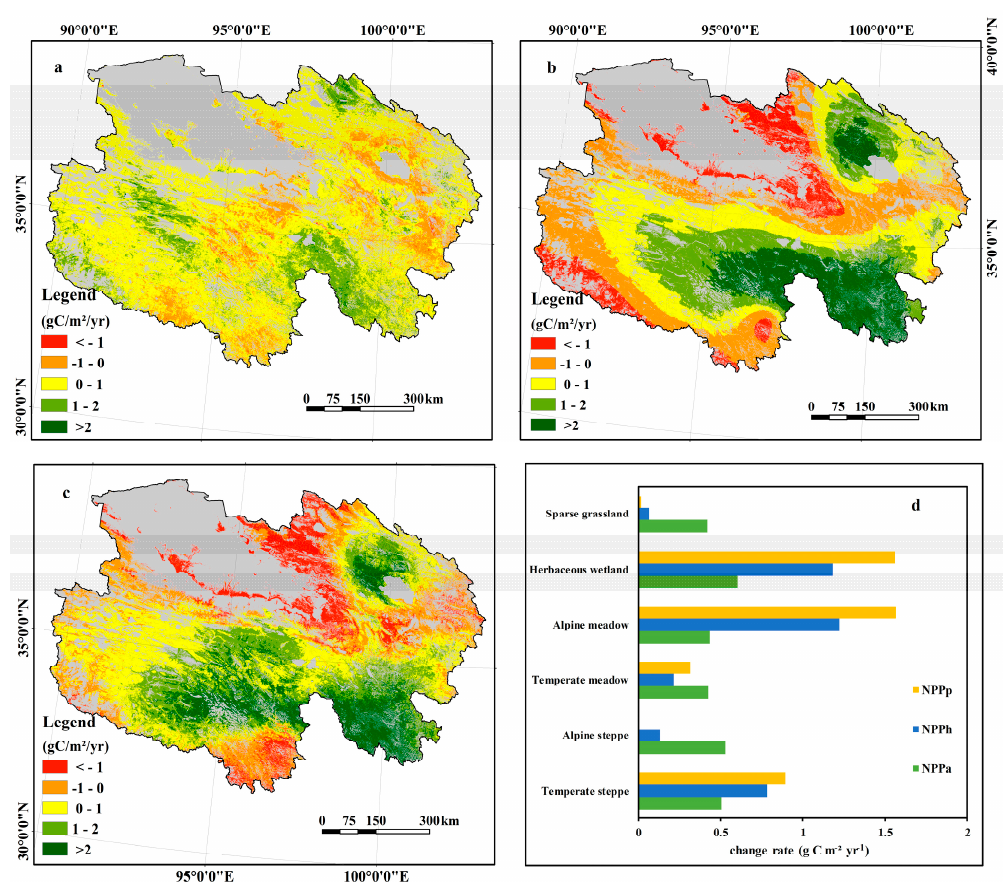
Figure 4. Spatial patterns of the changing trends for ( a ) NPP a , ( b ) NPP p , and ( c ) NPP h for the different grassland types ( d ) from 2001 to 2016 in Qinghai province. 3.3. The reasons for NPP a change. 235